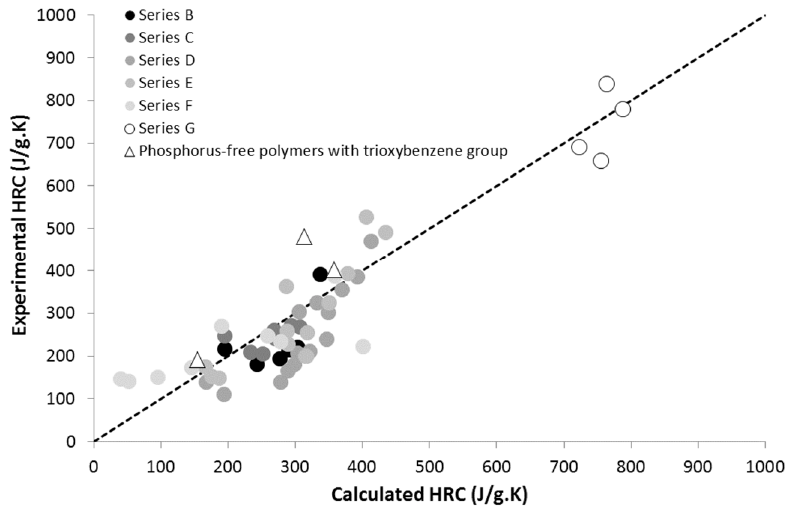
Figure 4. Experimental versus calculated HRC for polymers bearing PO 3 pendant groups.